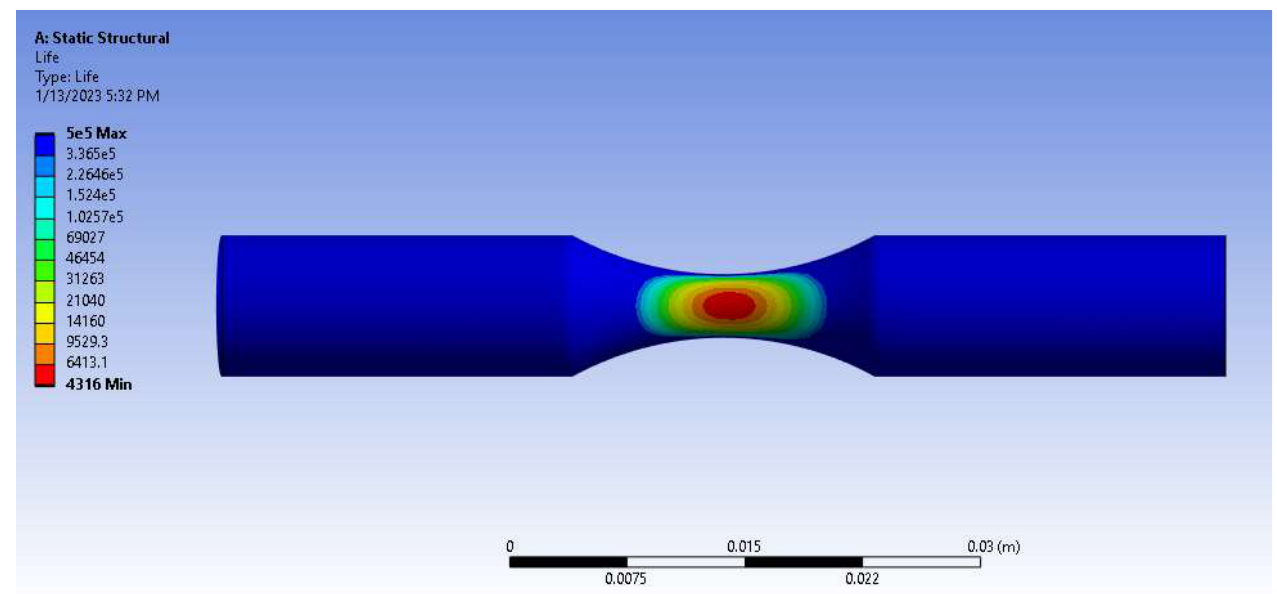
Figure 9. ABS numerical fatigue analysis of fatigue life under 90% UTS load.